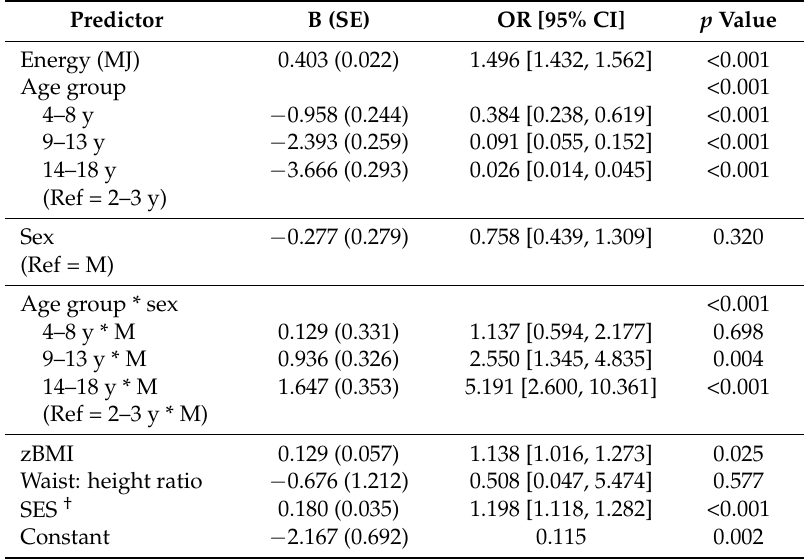
Table 2. Binary logistic regression analysis of predictors of meeting fibre AI * in children aged 2–18